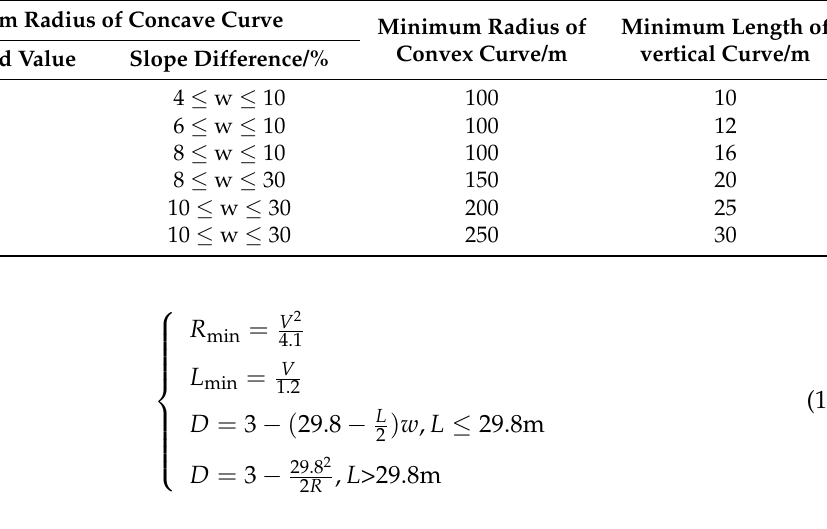
Table 4. Recommended minimum radius and length of the vertical curve of the fan transport road